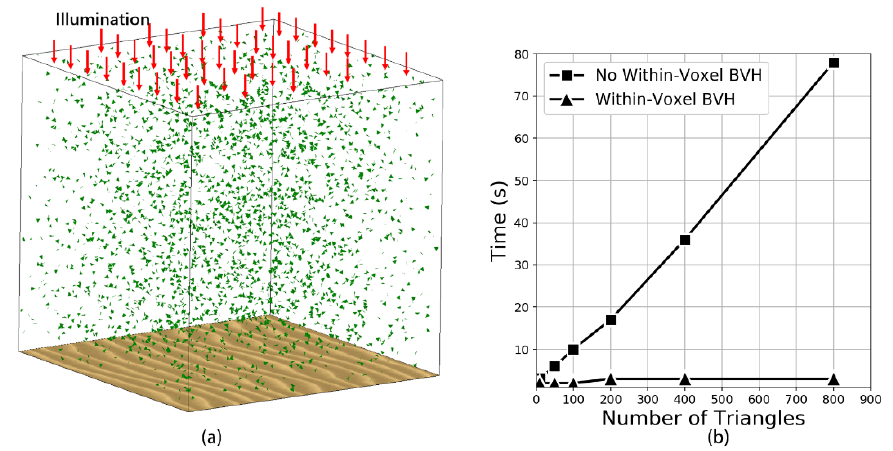
Figure 4. Simulation time varies with the number of triangles in one voxel: ( a ) 1 m × 1 m scene with randomly distributed triangles, ( b ) simulation time under different number of triangles.